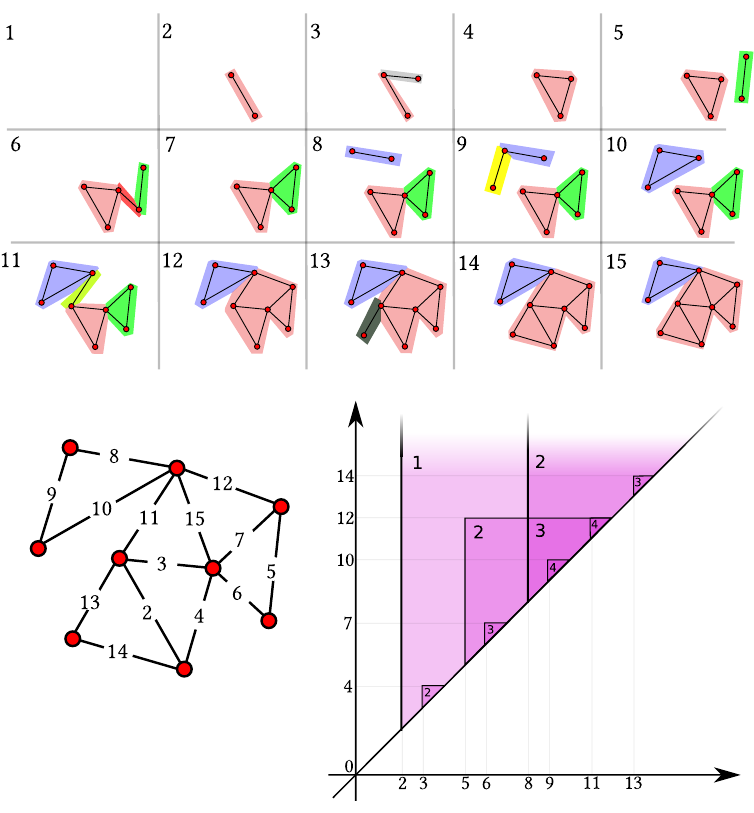
Figure 6. The weighted graph of Figure 1 (left), the corresponding filtration (above) and its 2-block number